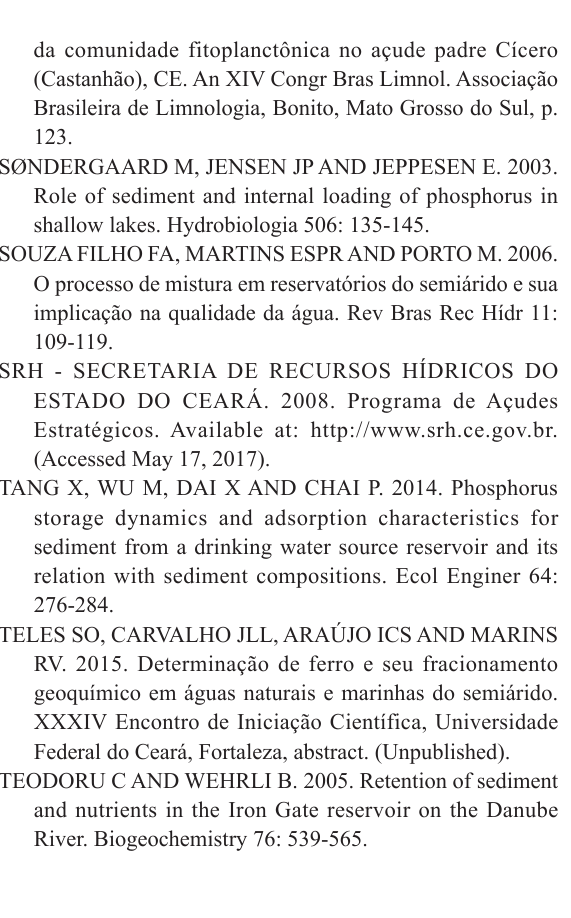
Table SI - Mean, maximum and minimum values for